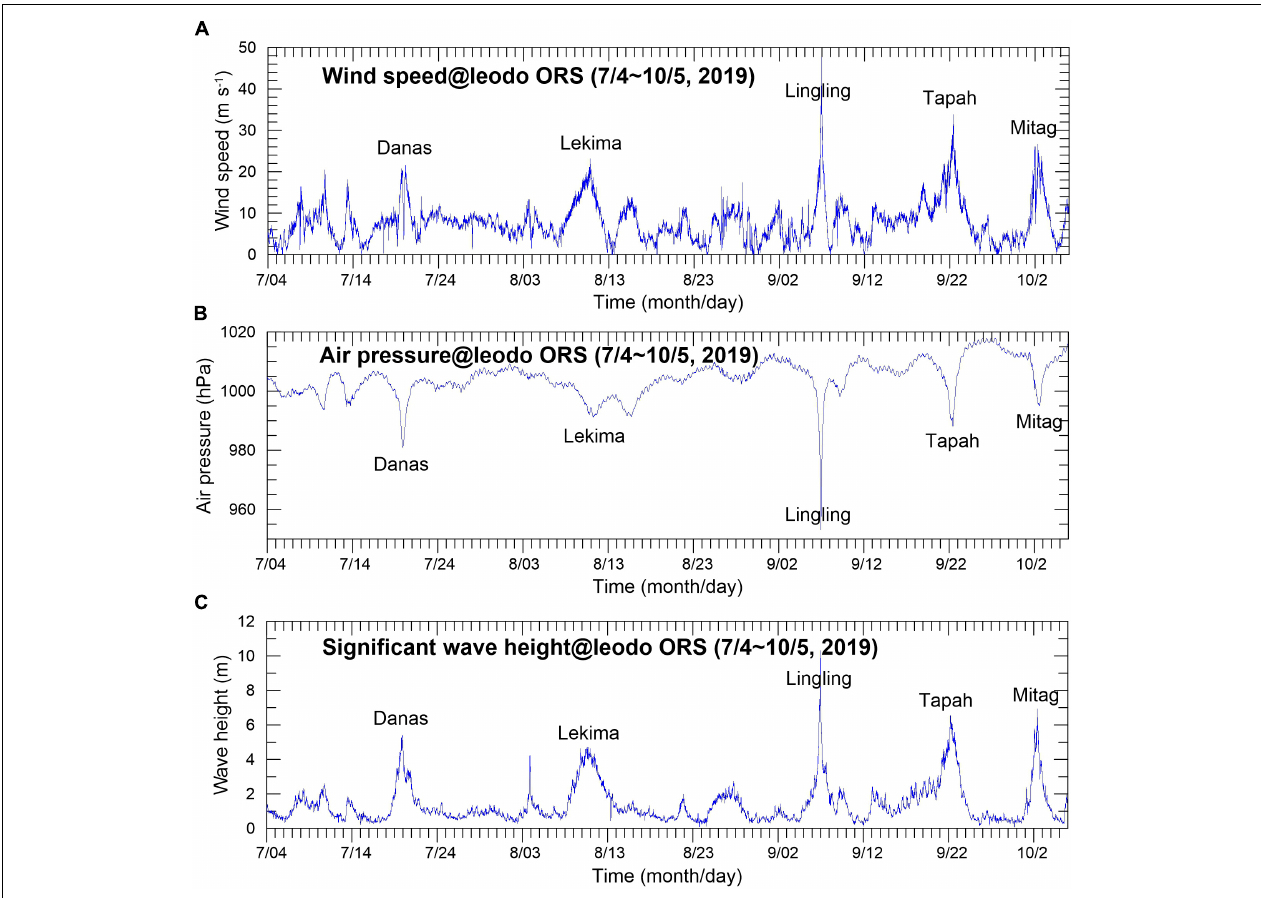
FIGURE 2 | Time series of (A) wind speed (42.7 m above datum level); (B) air pressure (35.4 m above datum level); and (C) significant wave height, observed at Ieodo ORS from July 4 to October 5, 2019. In 2019, a maximum wind speed of 48 m s − 1 and maximum significant wave height of 10.33 m were recorded during typhoon Lingling’s